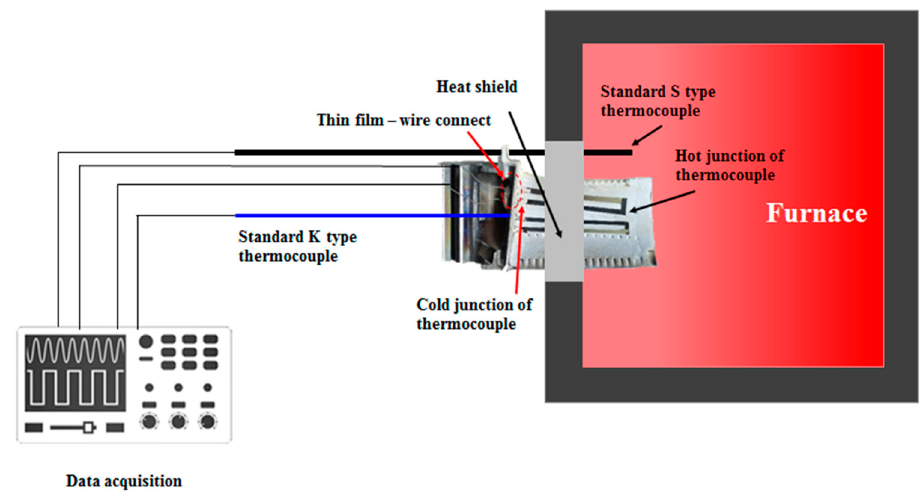
Figure 9. Schematic diagram of the experimental setup.